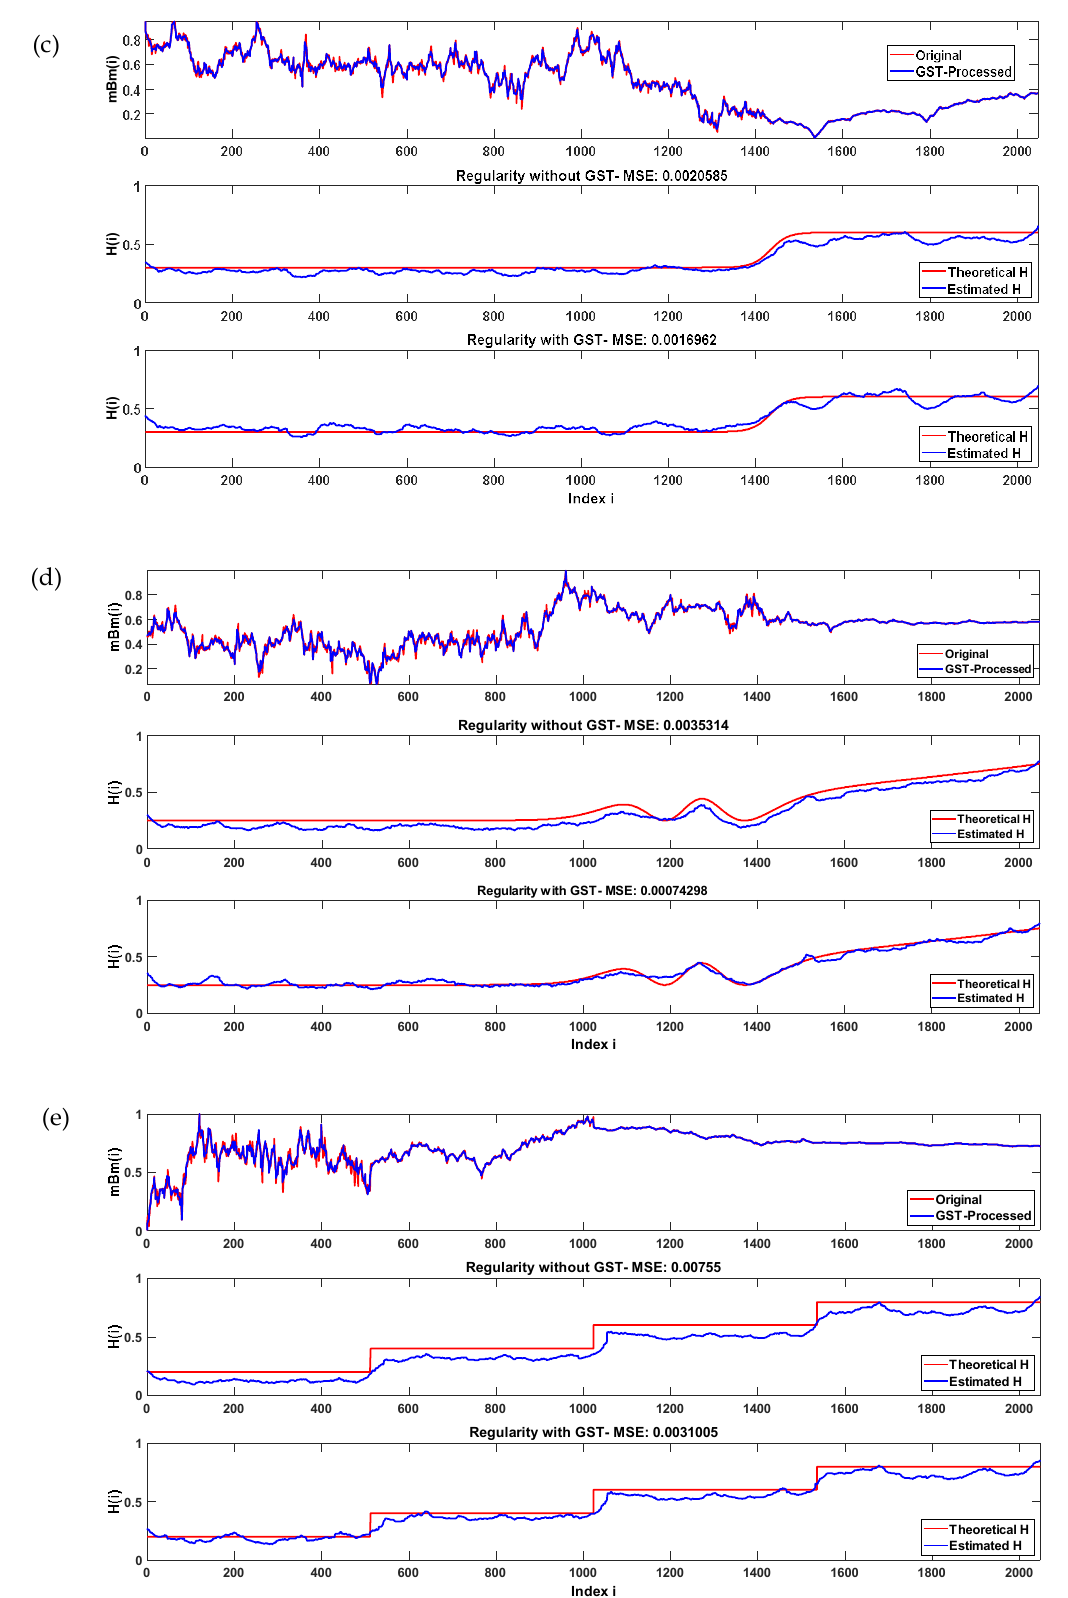
Figure 1. Results obtained from mBm paths simulated with five types of Hölder function H(t): ( a ) linear; ( b ) periodic; ( c ) logistic; ( d ) synthetic; ( e ) stairs. Each figure consists of three panels, described as follows. The first panel represents the